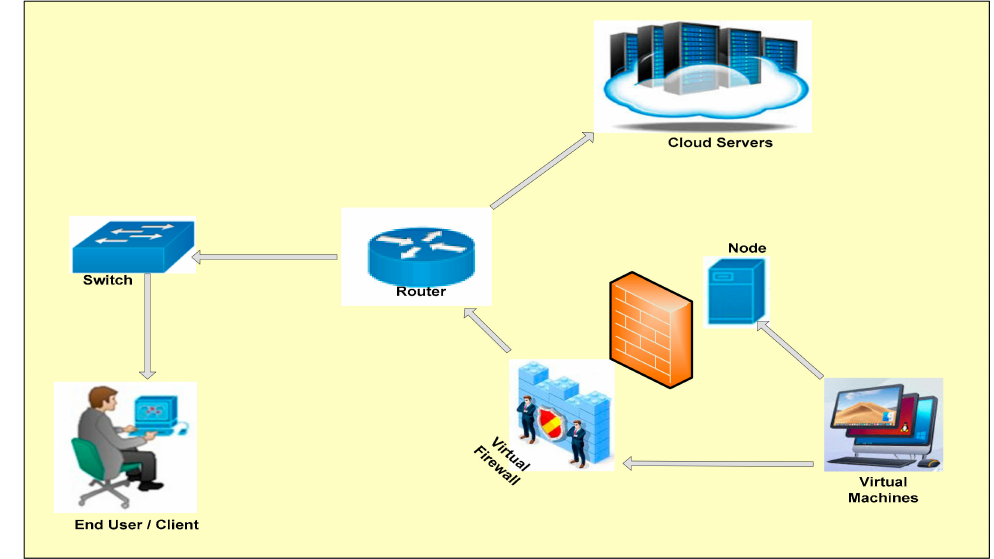
Figure 5. Virtual Firewall Network